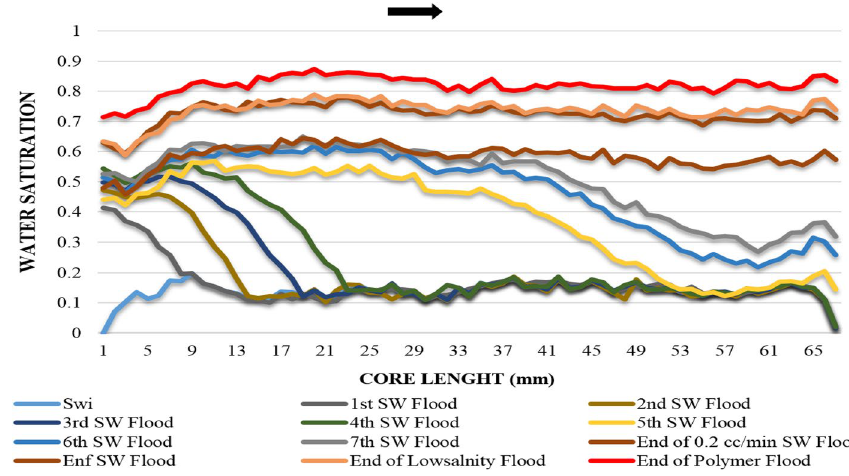
Fig. 14 ISSM showing the effect of polymer flooding on oil recovery during Exp.